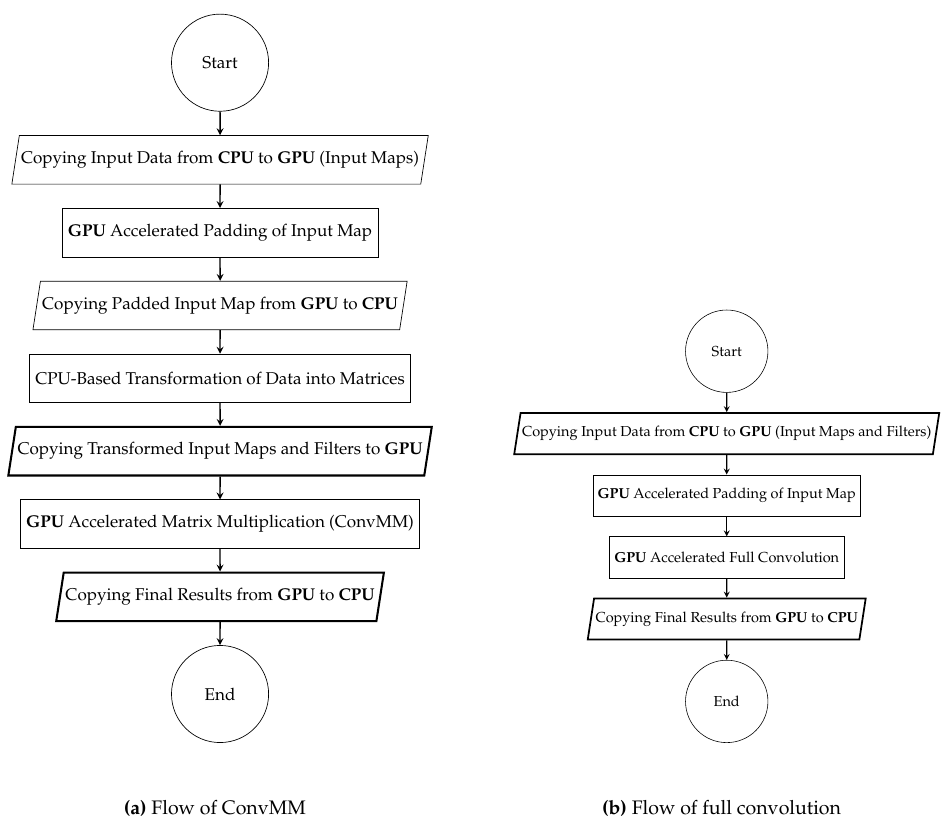
Figure 5. Flow of ConvMM and full